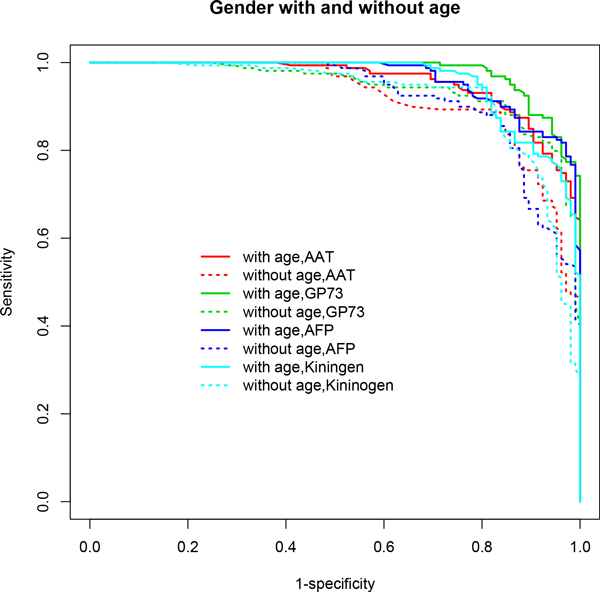
ROC curves based on multivariable model-based CART analyses (mob) incorporating gender and/or age. Age-adjusted models demonstrated superior performance in terms of AUC when gender effect is accounted for in each model. A clear distinction is seen in the ROC curves for age-adjusted models (solid lines) compared to age-unadjusted models (dotted lines). Table 1 lists the performance measures for these models. A detailed discussion of the results is provided in the text.